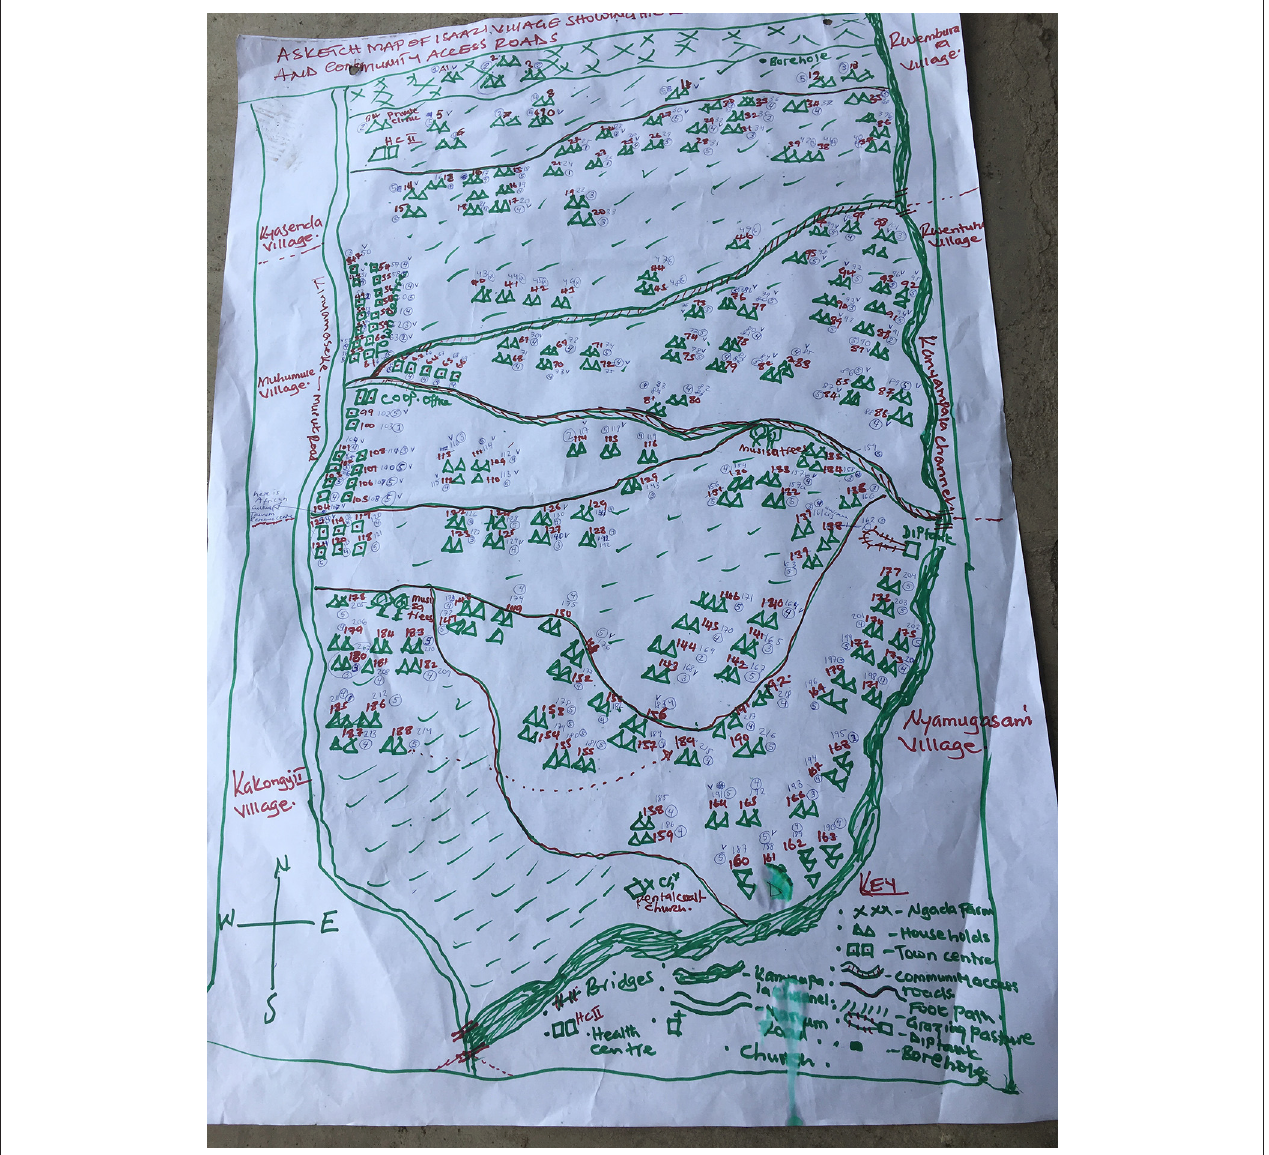
FIGURE 2 | Map of the study village indicating all households and their wealth rank. Households are numbered 1–199 in plain numerals. Wealth rank is indicated as 1–5 in encircled numbers. Households marked √ participated in the first eight FGDs.